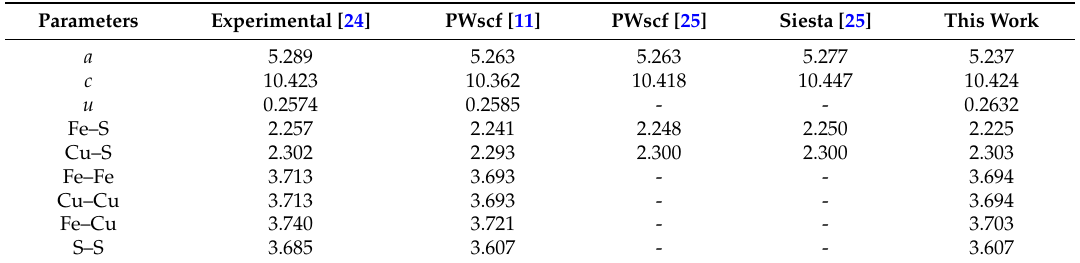
Table 1. Geometrical parameters of the chalcopyrite bulk (values in Å).